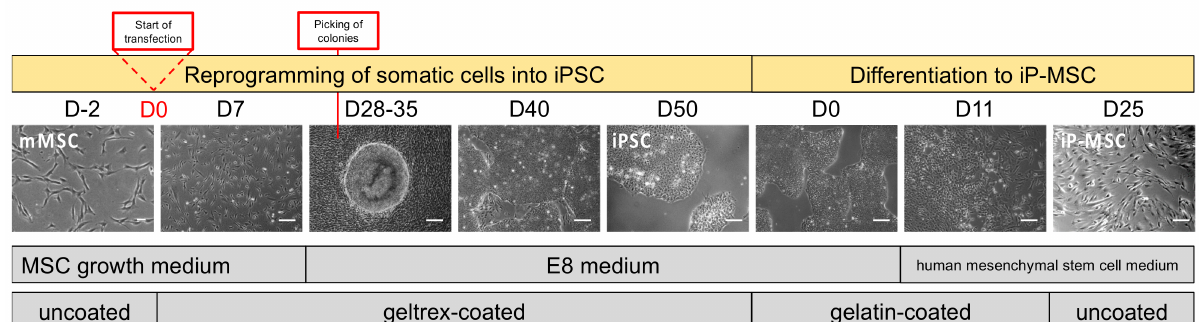
Figure 1. Time scale of reprogramming from nasal mucosal mesenchymal stem cells (mMSCs) to induced pluripotent stem cells (iPSCs) and differentiation towards induced pluripotent stem-cell-derived mesenchymal stem cells (iP-MSCs). The mMSCs are seeded on day (D)2 in MSC growth medium (scale bar 100 µ m). On D0, mMSCs were transfected using episomal plasmids for reprogramming. First, morphology changes were visible on D7 followed by medium change to E8 (scale bar 100 µ m). iPSC colonies appeared between D28 and D35 after transfection (scale bar 100 µ m). Potential iPSC colonies were mechanically picked and maintained in culture for further passages, reaching typical pluripotent stem cell morphology around D50 (scale bar 100 µ m). Differentiation of iPSCs into MSCs started with high-density iPSCs on gelatin-coated plates (scale bar 100 µ m). E8 medium was changed to human mesenchymal stem cell medium at D11 after initiation of differentiation (scale bar 100 µ m). Seven days later, the cells were transferred to uncoated plates, and the first mesenchymal-like cells appeared on D25 after starting differentiation (scale bar 100 µ m).